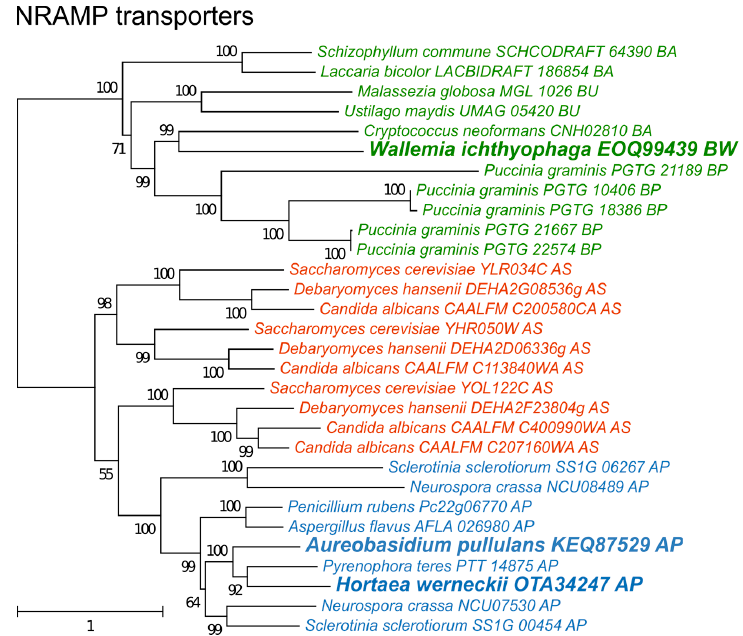
Figure 6. Maximum likelihood phylogeny of genes encoding cation transporters of the NRAMP family. The phylogeny was estimated by PhyML software with aLRT implementation for the calculation of branch supports as Chi-squared based support. Species name is followed by protein accession number and by a two letter description of the larger taxonomic group (BA—Basidiomycota,